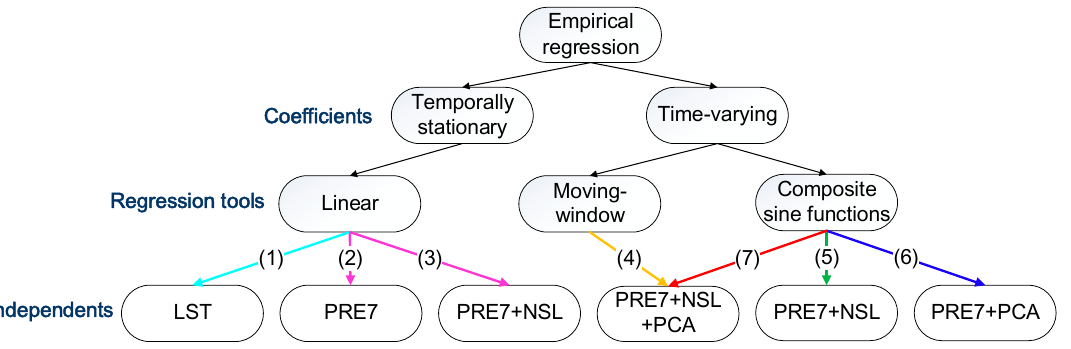
Figure 7. Models as comparisons ((1)–(6)) to the proposed one (7). PRE7: LST, NDVI, ISA, BSA, NDWI, ELV, and DDL.